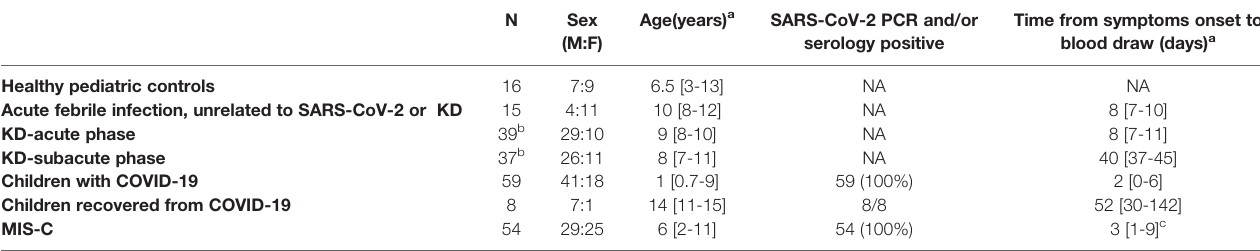
TABLE 1 | Subject characteristics of the pediatric cohort (n =